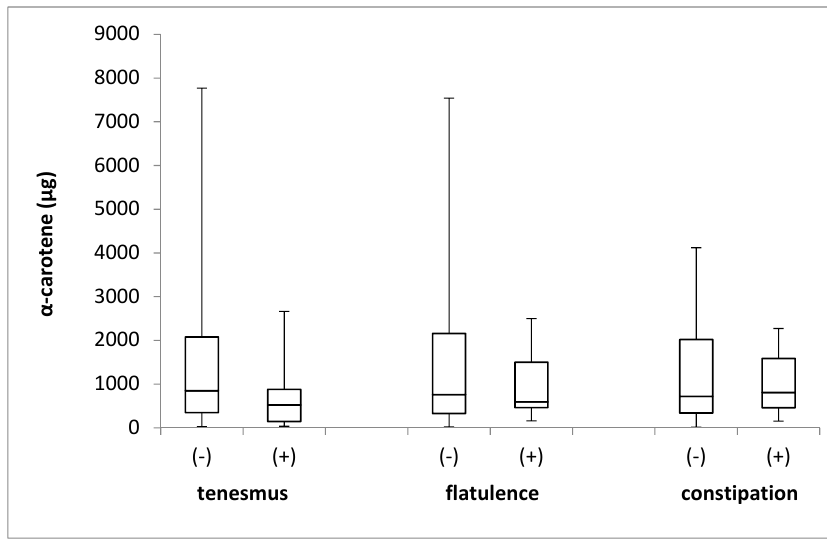
Figure 3. The box plots of β -carotene intake in groups of individuals stratified by the analyzed symptoms of tenesmus, flatulence and constipation. (-) symptom not declared; (+) symptom declared. The α -carotene intake in the groups of individuals stratified by the incidence of tenesmus, flatulence, and constipation is presented in Figure 4. No differences in the levels of α -carotene intake were identified between the groups, with respect to the incidence of tenesmus ( p = 0.244; Mann– Whitney U test), flatulence ( p = 0.858; Mann–Whitney U test), and constipation ( p = 0.980; Mann– Whitney U test).